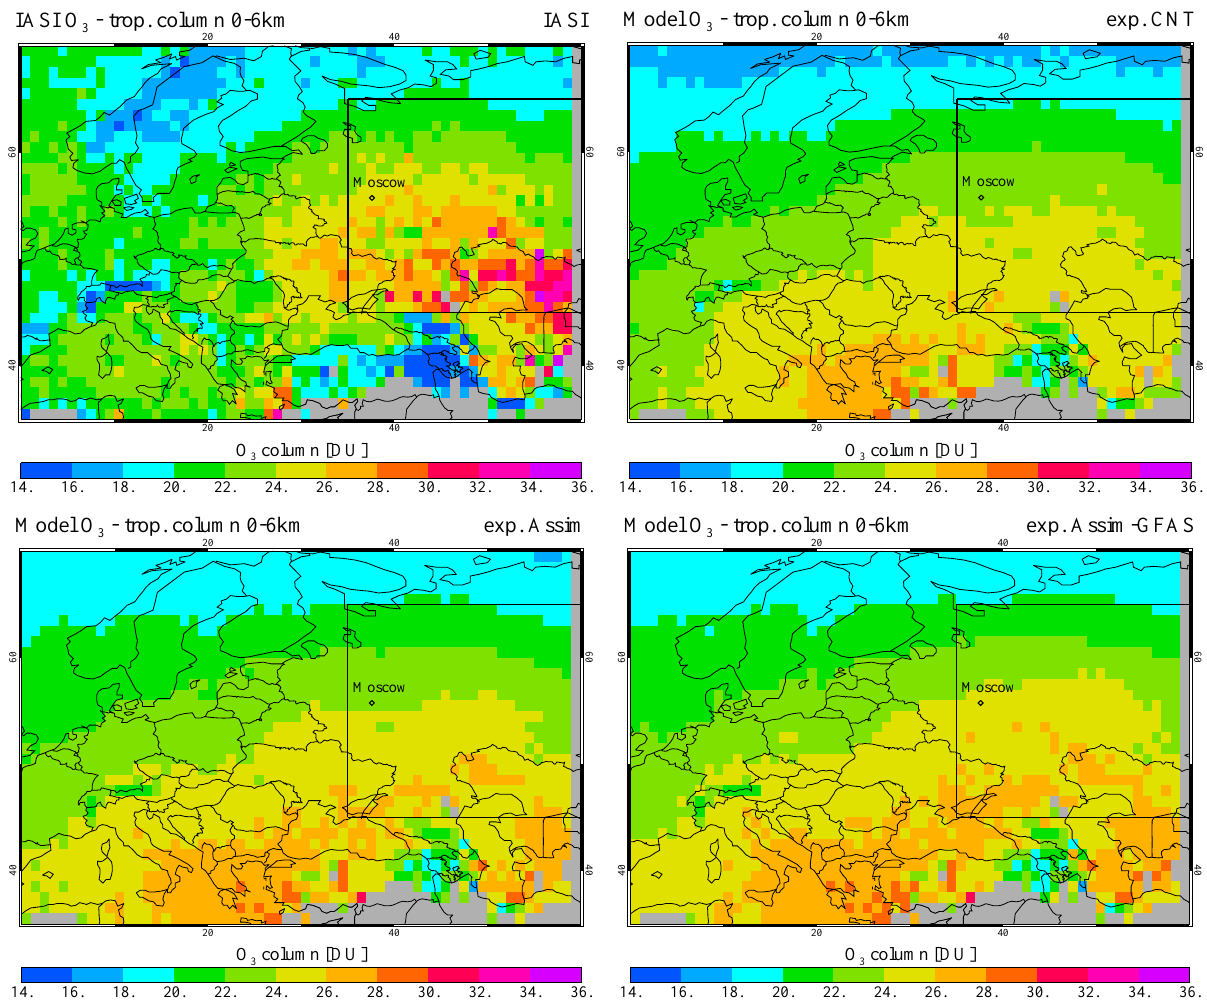
Fig. 9. Maps of mean O 3 tropospheric partial columns (0-6km) as observed from IASI between 20 July and 15 August 2010 compared to the kernel-weighted D+0 columns from the runs CNT, Assim and Assim-GFAS. Table 9. Mean bias and RMSE of modeled O 3 partial columns (0-6km) in DU, compared to IASI O 3 observations over western Russia between 20 July and 15 August, as function of the hindcast